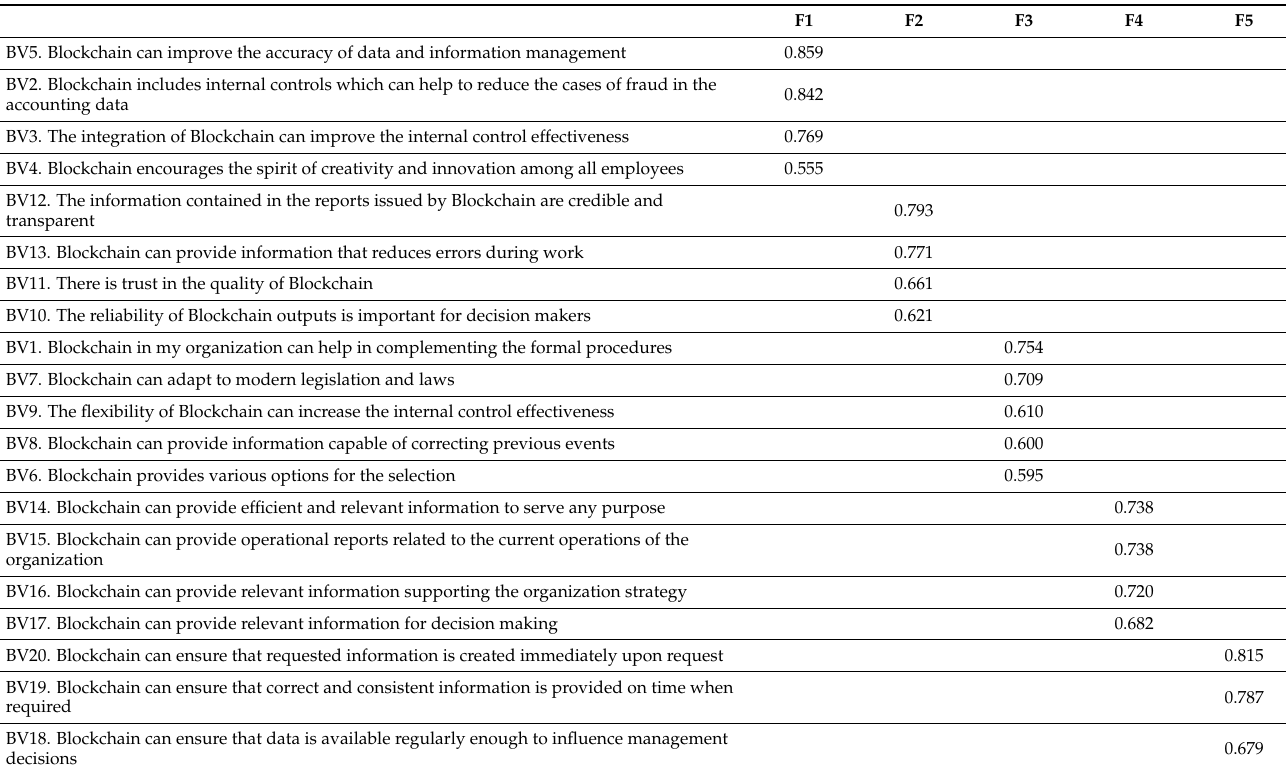
Table 5. Exploratory factor analysis (Source: IBM SPSS ® authors’ compilation).